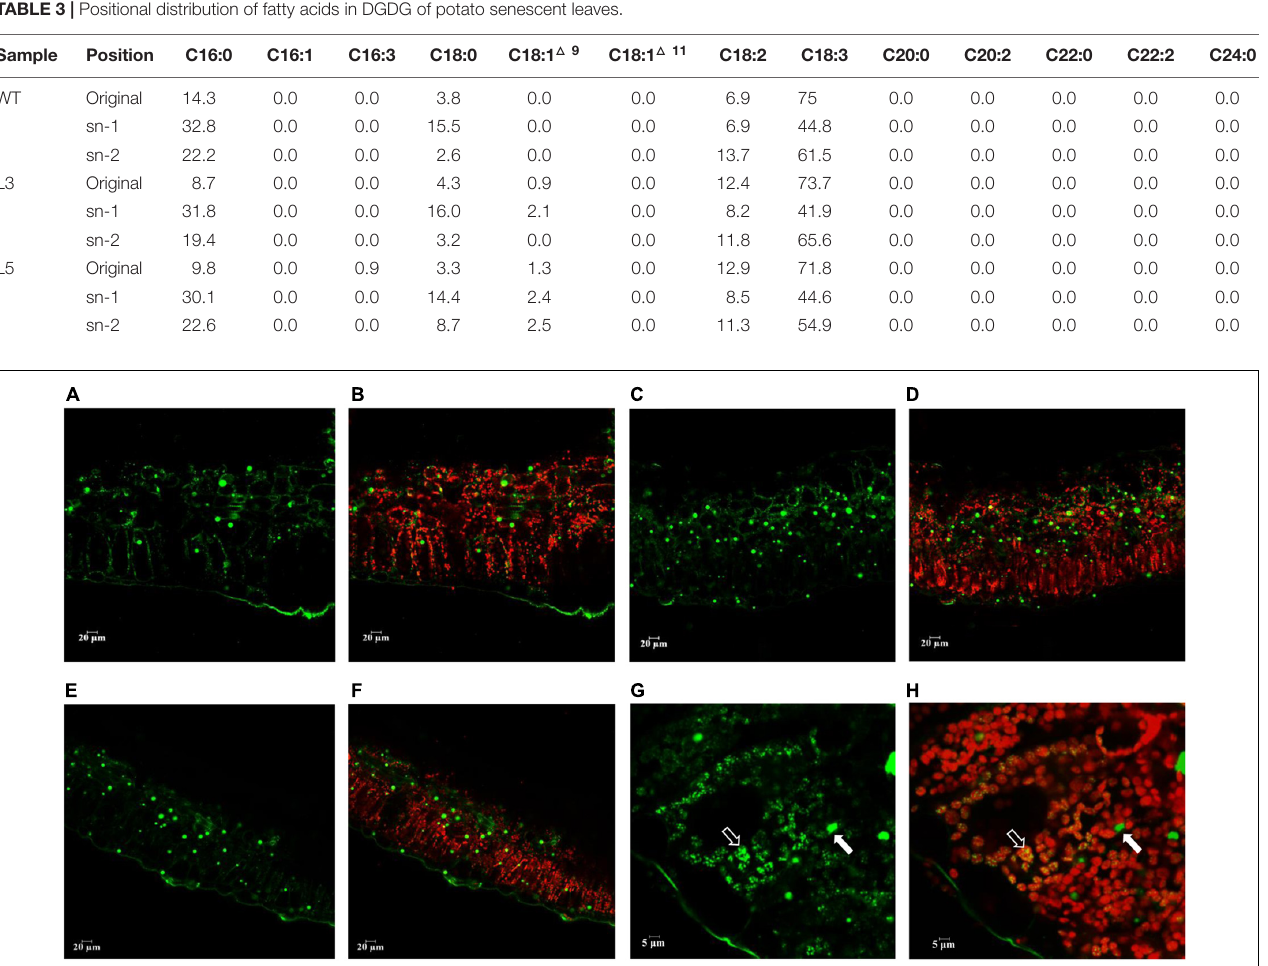
FIGURE 7 | Confocal microscopy analysis of the neutral lipid droplets distribution in the senescent potato leaves. Neutral lipid droplets were stained with Bodipy (green), and the autofluorescence of chloroplasts was visualized in red. (A,B) Fresh leaf sections of WT; (C,D) Fresh leaf sections of L3; (E,F) Fresh leaf sections of L5; (G,H) Magnified leaf sections of L5 as an example. Plastoglobuli (marked in white open arrow head) and LD (marked in closed open arrow head) showed exclusive distribution in the cellular compartments, with plastoglobuli highly attached with the chloroplast and LD accumulated in the cytosol. The scale bars are located in the lower left corner for each photograph, images (A–F) (20 µ m), images (G,H) (5 µ